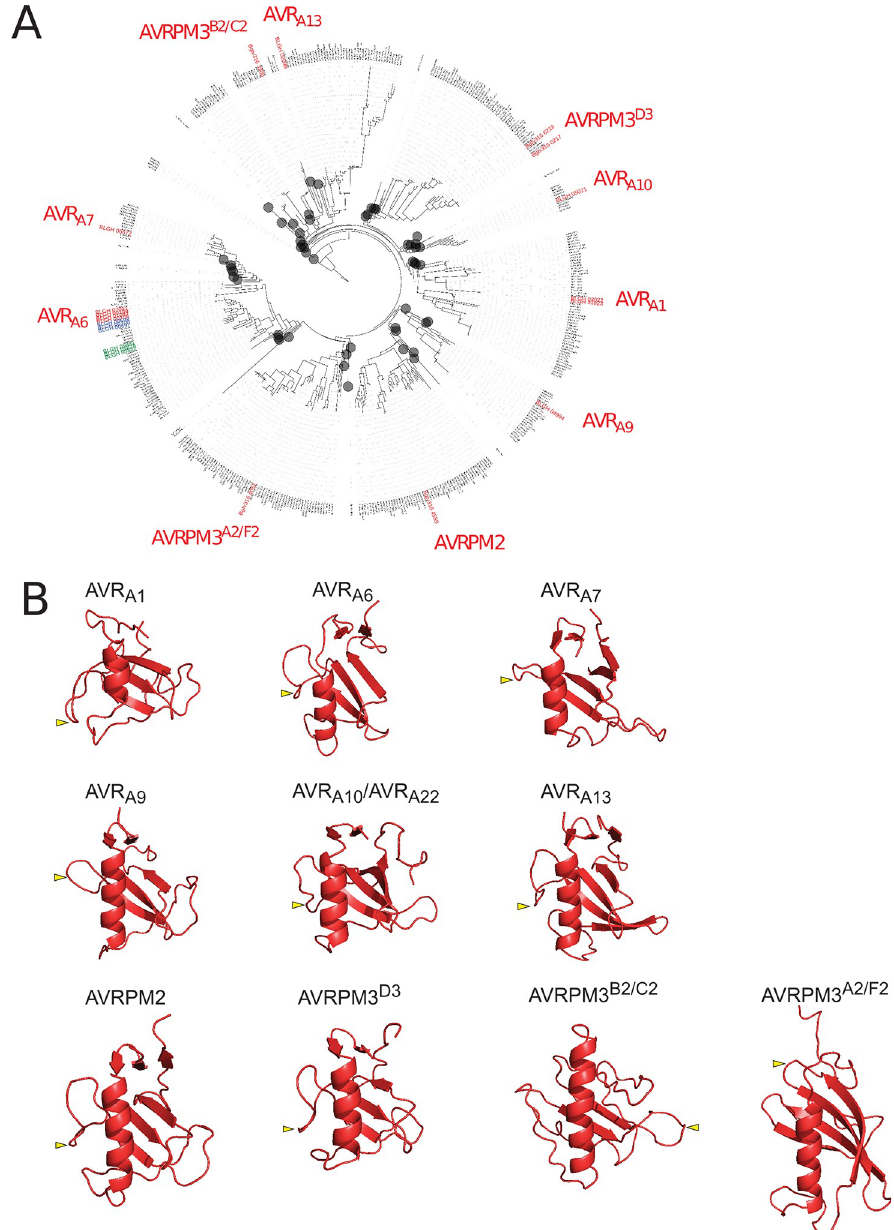
Fig 3. Bgh AVR A and Bgt AVRPM effectors are sequence-unrelated but exhibit predicted structural similarity to RNases. (A) Maximum likelihood phylogeny including all predicted CSEPs from B . graminis formae speciales poae , lolium , avenae , tritici 96224, hordei DH14, secalis S1459, triticale T1-20, and dactylidis . Depicted in red are the BLGH-IDs of all so far isolated Bgh AVR A and Bgt AVRPM effectors. Depicted in blue are the clade-1 family members of AVR A6 , while the clade-2 family members are colored in green. CSEP clades that were collapsed (grey circles) to improve legibility of the tree do not include AVR members and are indicated by grey circles. (B) Structural prediction of isolated AVR A s and AVRPM by IntFOLD version 5.0 in red (p-values: AVR A1 = 4.888e -4 most similar to PDB IDs 5gy6, 3who and 1rds, AVR A6 = 3.293e -5 to 6fmb, AVR A7 = 2.114e -4 to PDB ID 5gy6, AVR A9 = 1.18e -5 most similar to PDB IDs 6fmb, 3who, and 1ch0, AVR A10 = 9.759e -5 most similar to PDB ID 1fusa and to 3whoa, AVR A13 -1 = 7,359e -7 most similar to 6fmb, AVRPM2 = 8.741e -9 most similar to 6fmb, 1chOA, and 1rmsA, AVRPM3 D3 = 8.82e -5 most similar to PDB 6fmb and 5gy6A, AVRPM3 A2/F2 = 1.145e -5 to 3ub1A2, AVRPM3 B2/C2 = 7.079e -2 , no structural similarities predicted). Yellow arrow depicts relative position of the characteristic RALPH intron in effector structures.